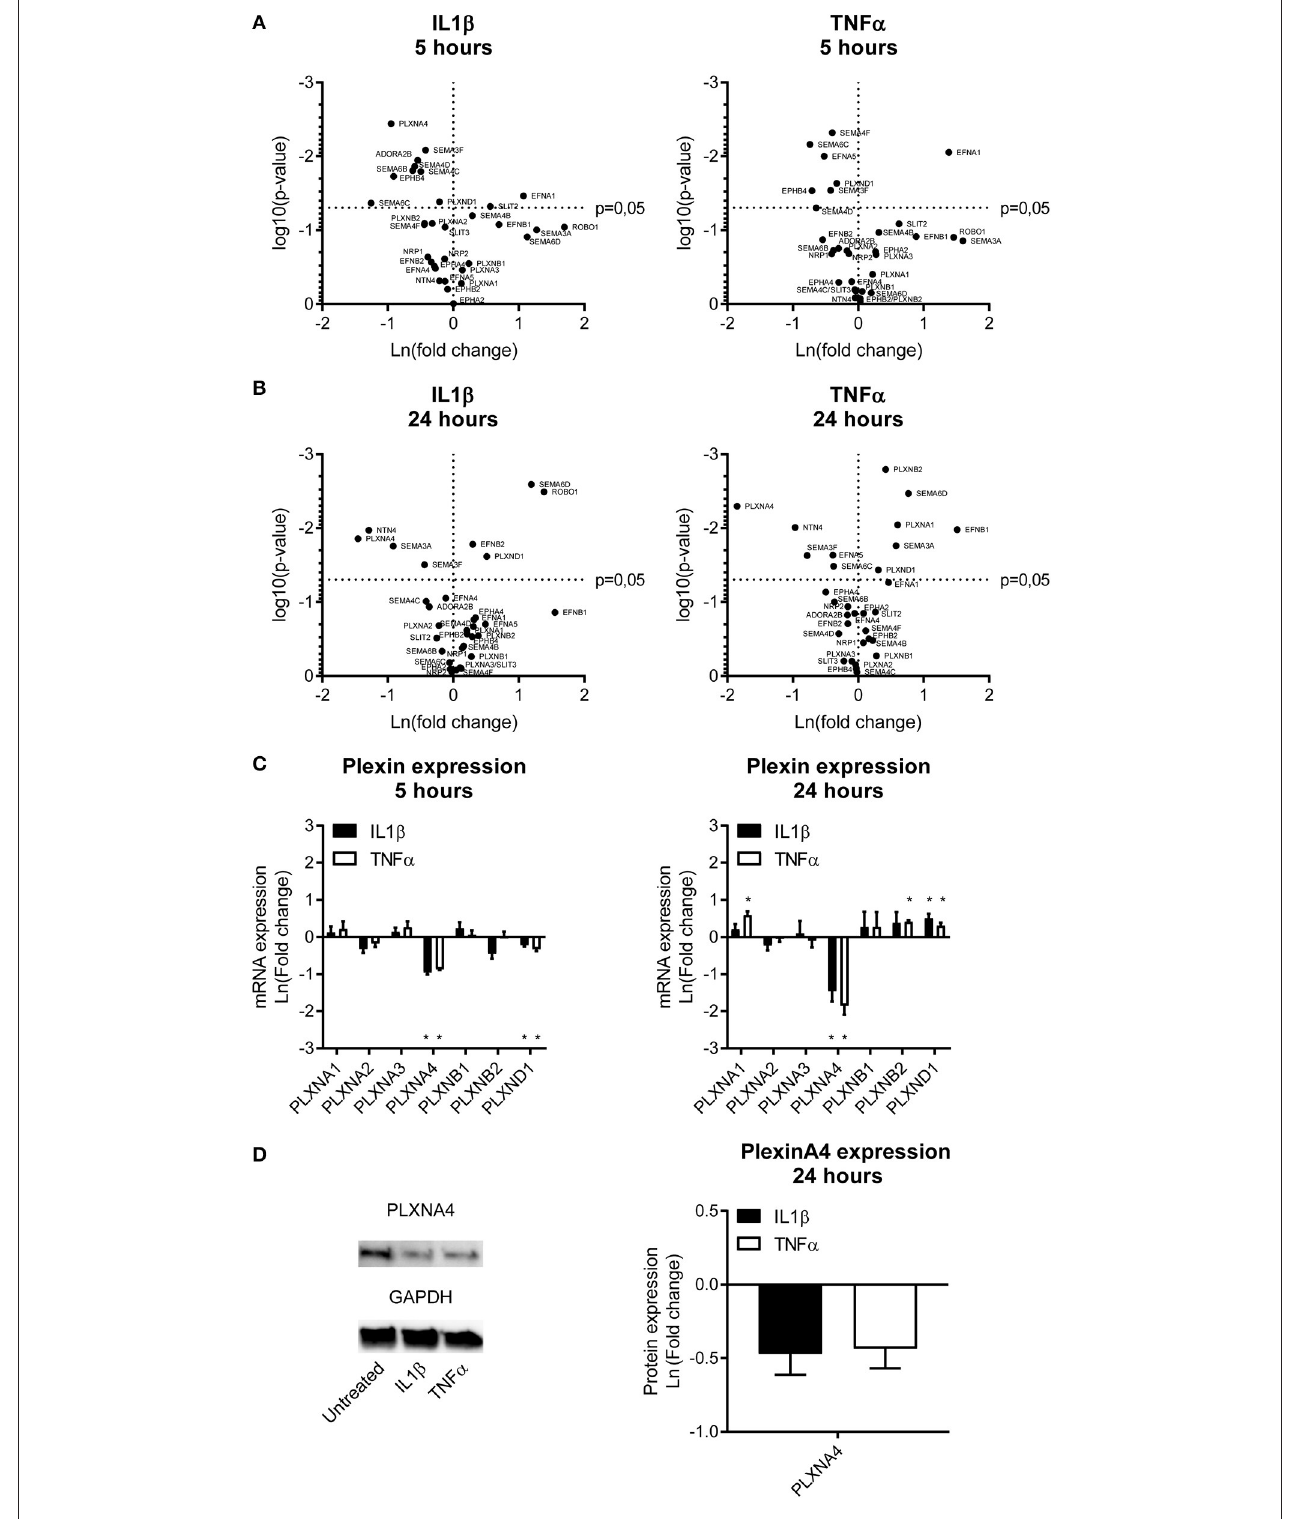
FIGURE 1 | Endothelial expression of NGCs under pro-atherogenic conditions. (A,B) Volcano plots depicting up and down regulation of NGCs after stimulation of primary human endothelial cells with IL1 β (20ng/mL) or TNF α (10ng/mL) for (A) 5 or (B) 24h. Results are depicted as mean of the natural logarithm transformed fold change in expression compared to unstimulated cells and plotted against significance. N = 4. (C) Quantitative PCR of mRNA expression of plexin receptors in endothelial cells after 5h or 24h of stimulation with IL1 β (20ng/mL) or TNF α (10ng/mL). Data is depicted as mean of the natural logarithm transformed fold change in expression compared to unstimulated cells. Mean ± S.E.M. of N = 4, * P < 0.05. (D) Immunoblots and quantification of PLXNA4 and GAPDH protein in primary human endothelial cells stimulated with IL1 β (20ng/mL) or TNF α (10ng/mL) for 24h. Results are depicted as fold change in intensity. Mean ± S.E.M. of N = 4.